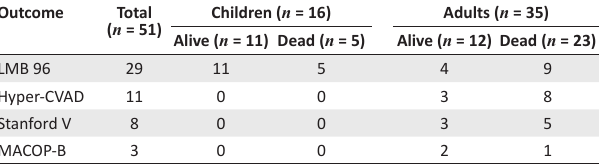
TABLE 3: Outcome by treatment protocol. Outcome